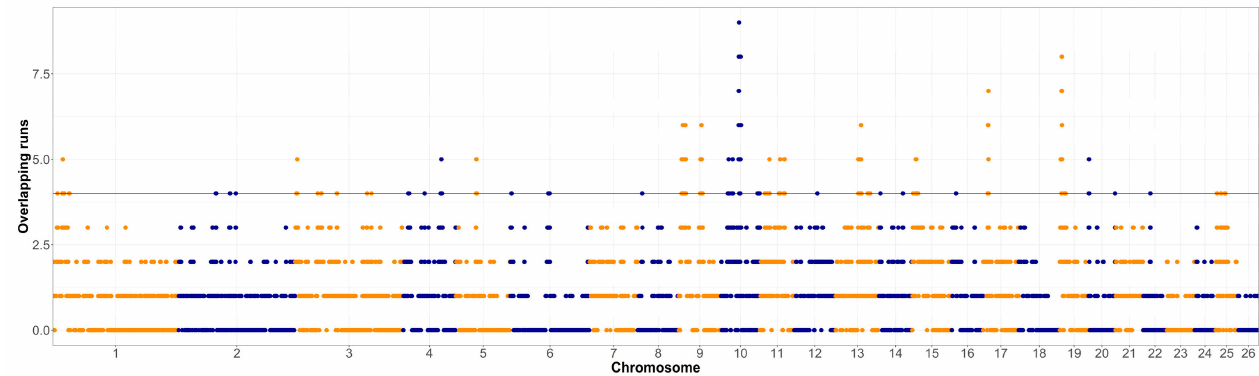
Figure 2. Runs of homozygosity islands in the Improved Valachian sheep population (horizontal line denotes the top 1% of most homozygous regions, alternating colors distinguish markers on neighboring